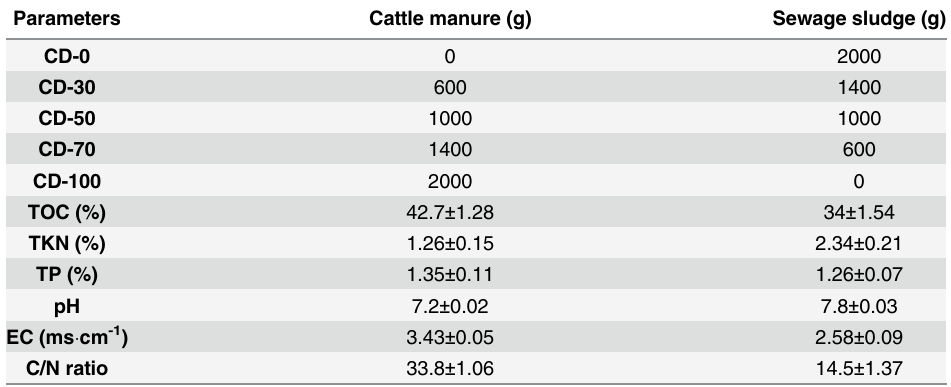
Table 1. Physicochemical characteristics of tested composting material (mean ±